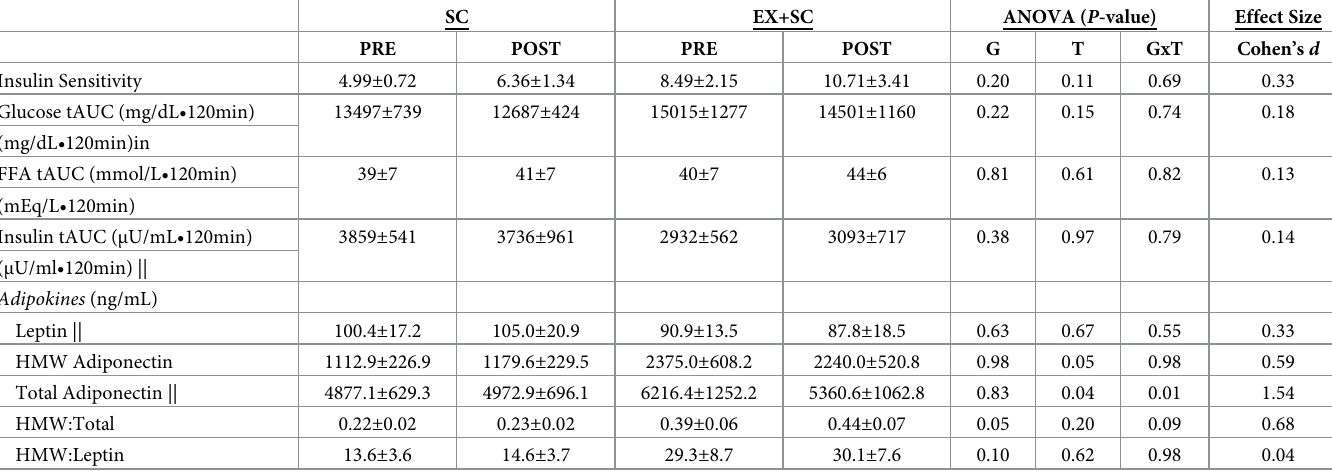
Table 2. Effect of SC and EX+SC on metabolic outcomes and